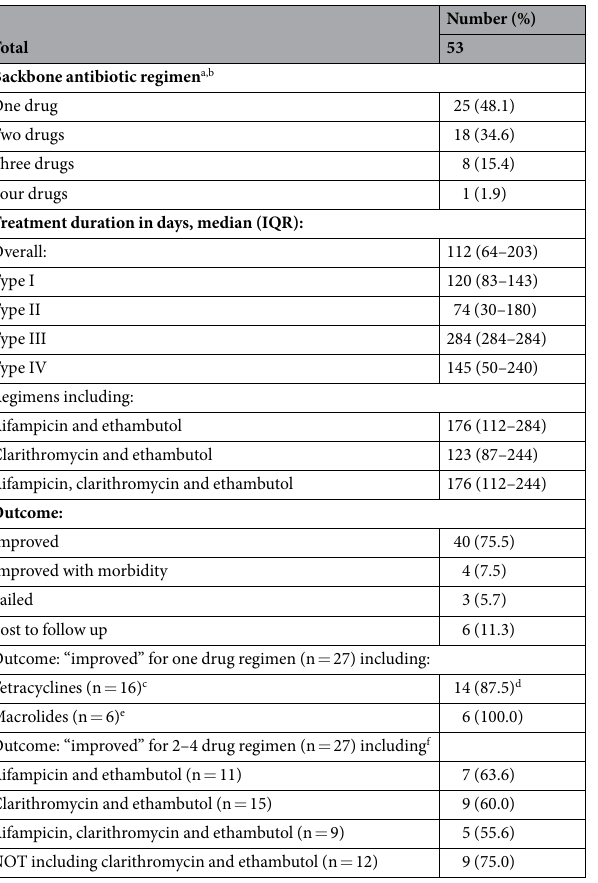
Table 2. Treatment of patients with M. marinum infection in Denmark. a The antibiotic regimen used for the majority of the treatment period. b One patient received multiple combinations of antibiotics; backbone therapy could not be assessed. c Ten patients received doxycycline and 6 patients received tetracycline. d Two patients were lost to follow up. e Five patients received clarithromycin and one patient received azithromycin. f Clarithromycin was the only macrolide used in the 2–4 drug